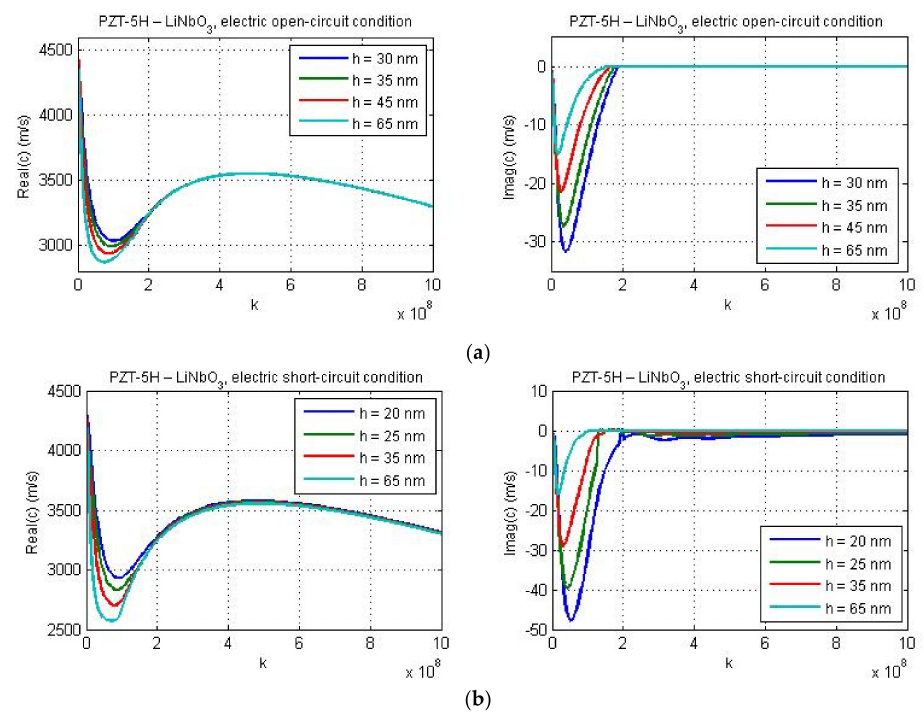
Figure 8. The effect of the guiding layer thickness on the real and imaginary parts of phase velocity for the data of materials PZT-5H—LiNbO 3 ; ( a ) electric open-circuit conditions and ( b ) electric short-circuit